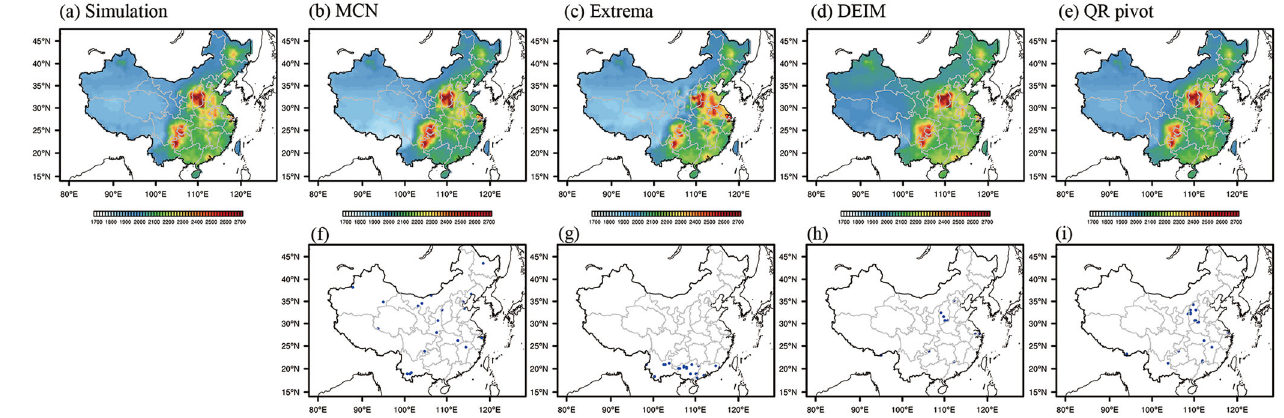
Fig. 3 Reconstructed surface CH 4 concentrations and locations of sensors. Spatial distributions of mean surface CH 4 concentrations across China from ( a ) WRF-GHG and reconstructed results with ( b ) MCN, ( c ) Extrema and ( e ) QR pivot algorithms under the condition of 10 POD modes and 20 sensors ( P = 2 n ); ( d ) DEIM under P = n ; associated locations of sensors ( f – i